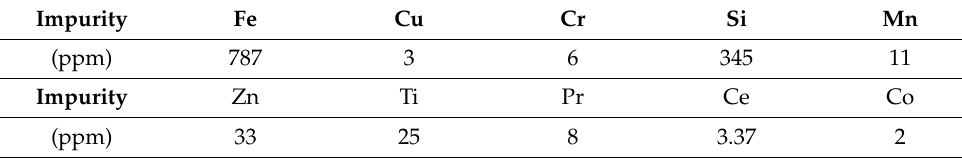
Table 3. The impurity content of lanthanum.